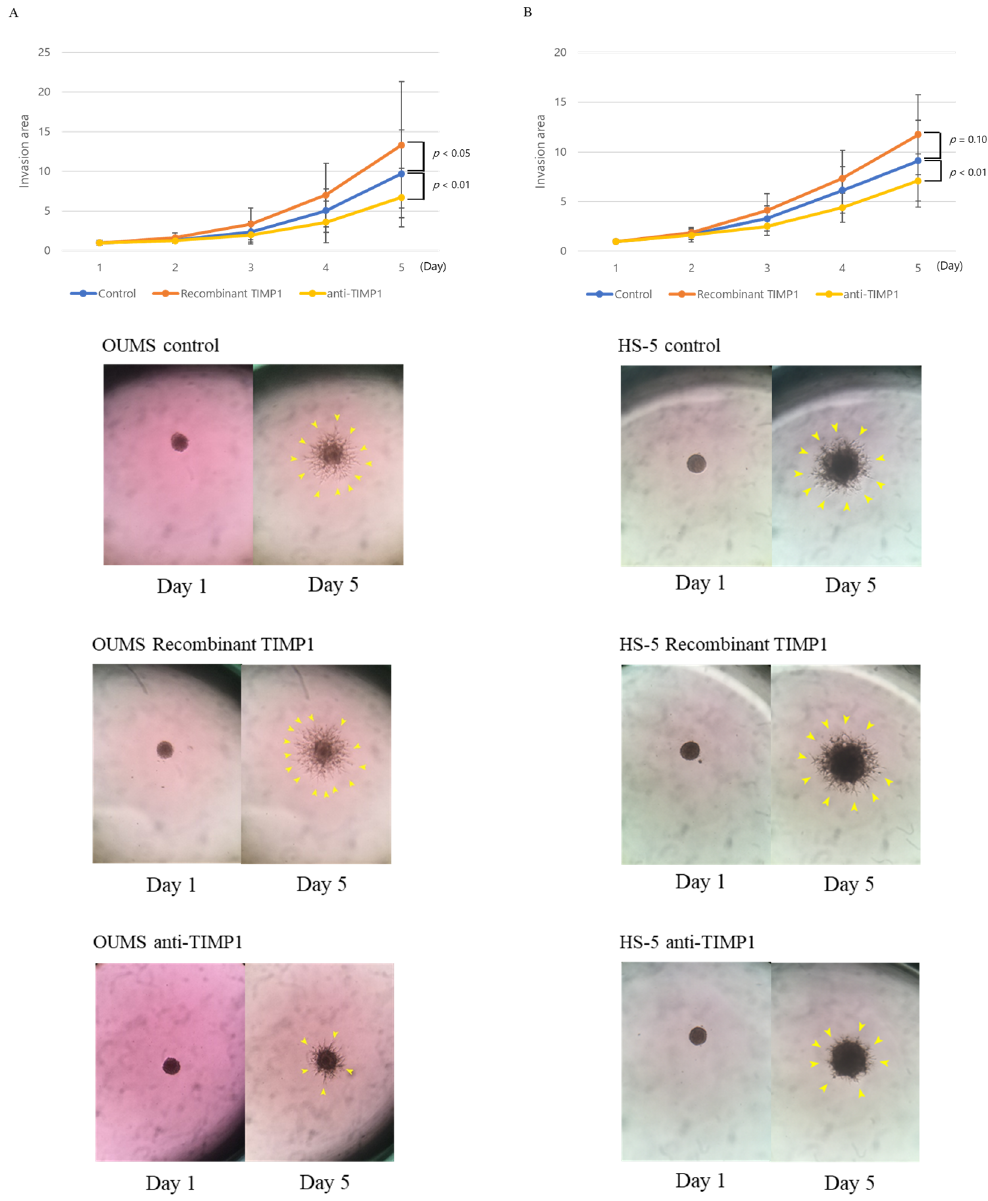
Figure 5. Fibroblast invasive capacity. Three-dimensional matrix invasion assays were used to evaluate the invasive capacity of ( A ) OUMS-36T-3F and ( B ) HS-5 with or without recombinant TIMP1 (0.5 µg/mL) or anti-TIMP1 antibodies (4.0 µg/mL). Blue bar, control; orange bar, recombinant TIMP1; yellow bar, anti-TIMP1 antibodies. Experiments were performed seven times. Error bars show standard deviations (SDs). Representative images of OUMS-36T-3F and HS-5 cells cultured with or without recombinant TIMP1 or anti-TIMP1 antibodies. The yellow arrows point to the